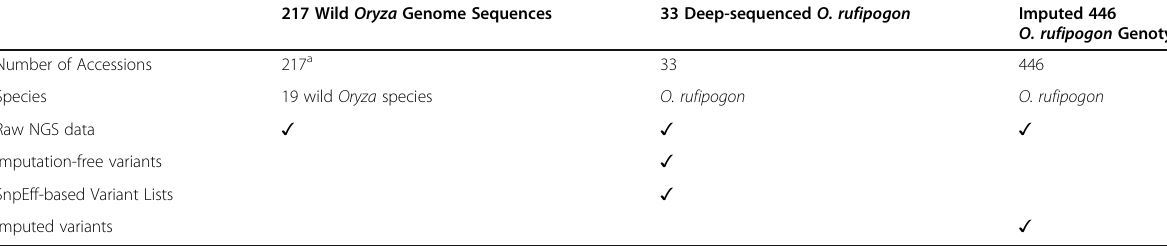
Table 1 List of information released in OyrzaGenome2.1 217 Wild Oryza Genome